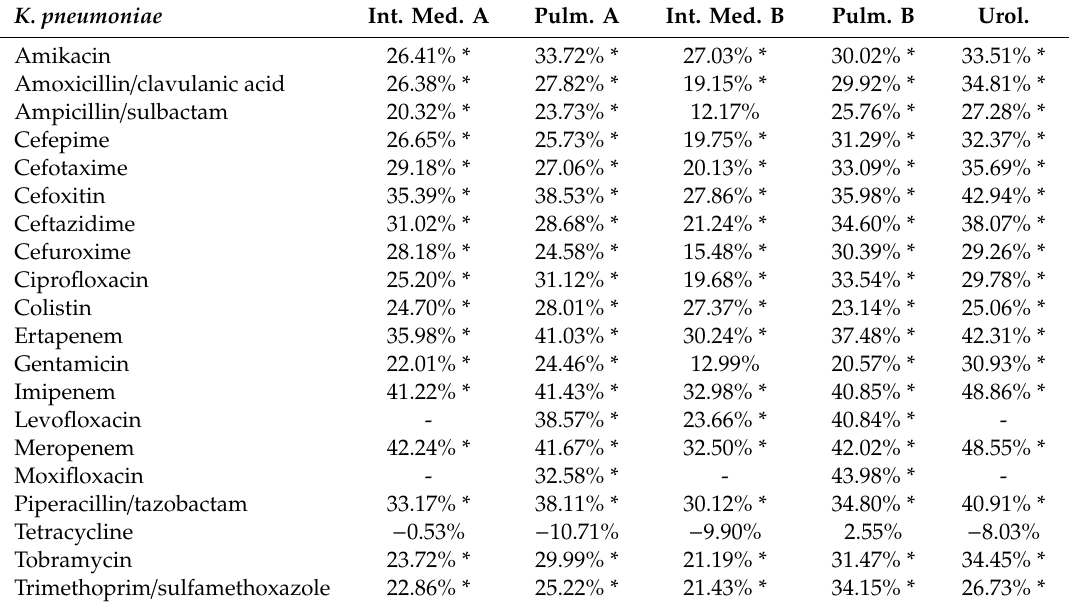
Table A9. Mean di ff erences of resistance rates for K. pneumoniae in ICUs versus other wards per antibiotic during the 2 years